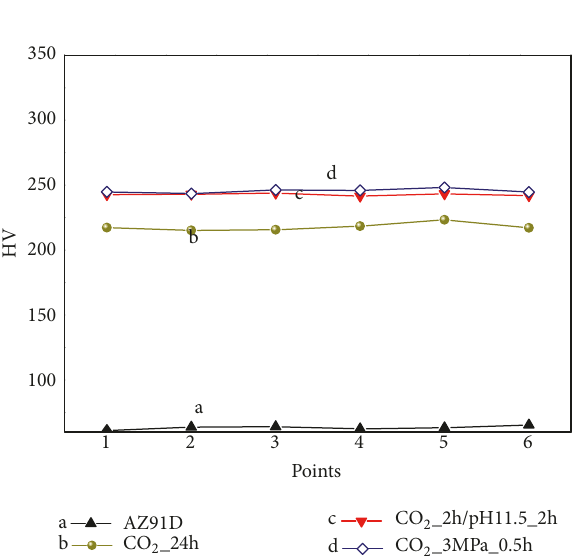
Figure 2: Hardness test results of the AZ91D alloy with and without LDH conversion